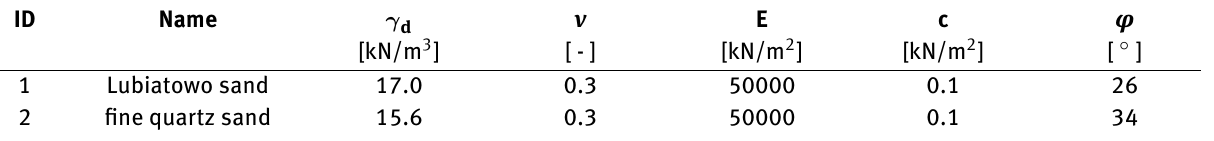
Table 2: Calculation parameters for the Lubiatowo sand and fine quartz sand.